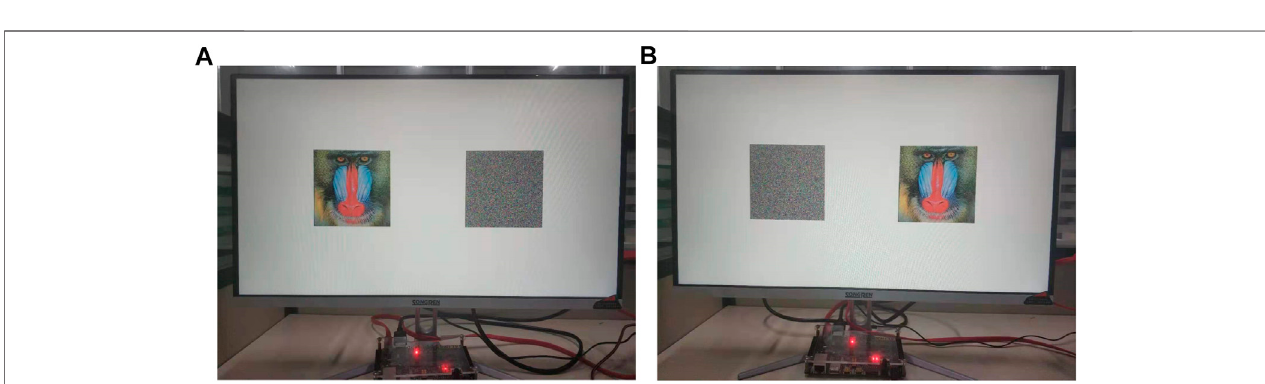
FIGURE 17 | The results of image encryption and decryption based on PRNG with feedback controller. (A) the original and encrypted image on the FPGA. (B) the encrypted and decrypted image on the FPGA.